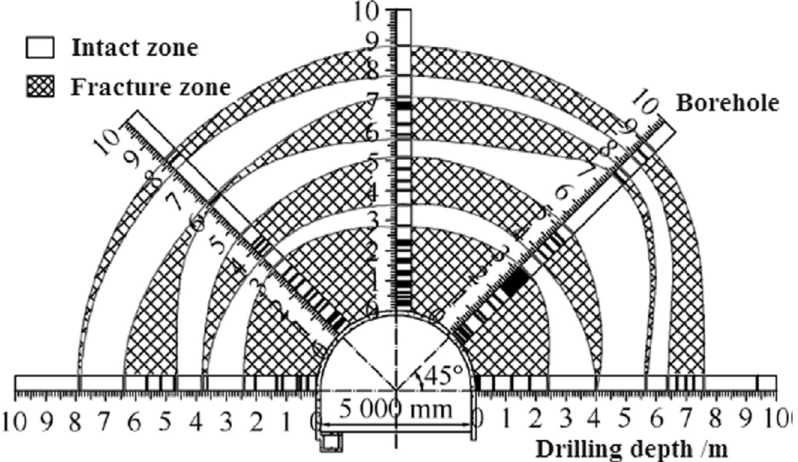
Figure 1. Sketch of the zonal disintegration phenomena in Huainan mine of China (Reproduced with permission from [12], Elsevier, 2017).